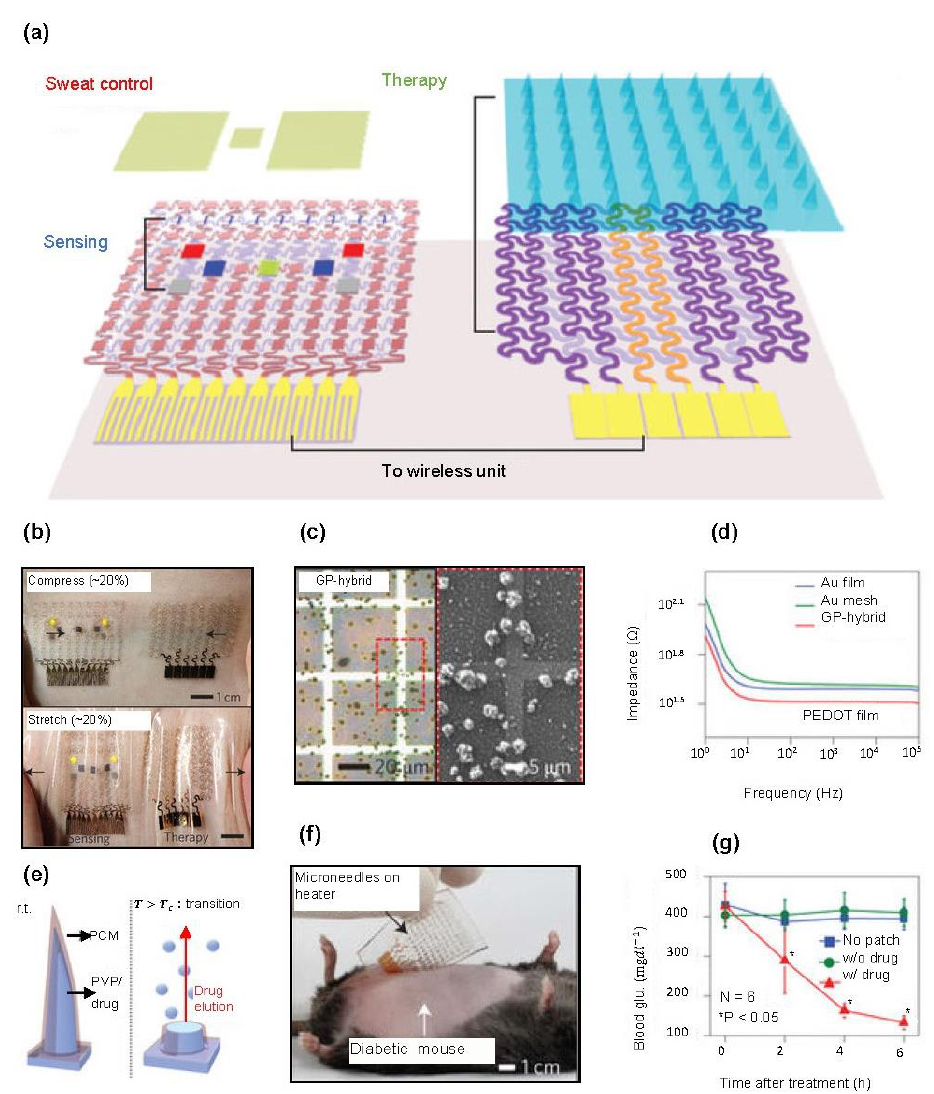
Figure 6. Graphene-based electrochemical sensors and microneedles for diabetes monitoring and therapy: ( a ) schematic illustration of the diabetes patch system consisting of sweat control, sensing (humidity, glucose, pH, and tremor sensor) and therapy components (heater, temperature sensor, and microneedles with drugs) on a silicone substrate; ( b ) photographs of the diabetes patch attached on the human skin under 20% applied compressive (top) and tensile (bottom) strain; ( c ) optical microscopy (left) and SEM (right) images of the graphene-hybrid with the PEDOT electrodeposition; ( d ) bode plots of the three electrodes in PBS after PEDOT electrodeposition; ( e ) schematic illustrations of the thermally active bioresorbable microneedles; ( f ) optical camera image of the therapeutic patch with microneedles on heater laminated on the skin near the abdomen of the diabetic (db/db) mouse; and ( g ) blood glucose concentrations of the db/db mice for the experimental group and control groups. The error bars and asterisks indicate the standard deviation in each group and significant difference ( p < 0.05) among the groups at each time point relatively. Reproduced with permission from Lee et al. [161], copyright 2016, Macmillan Publishers